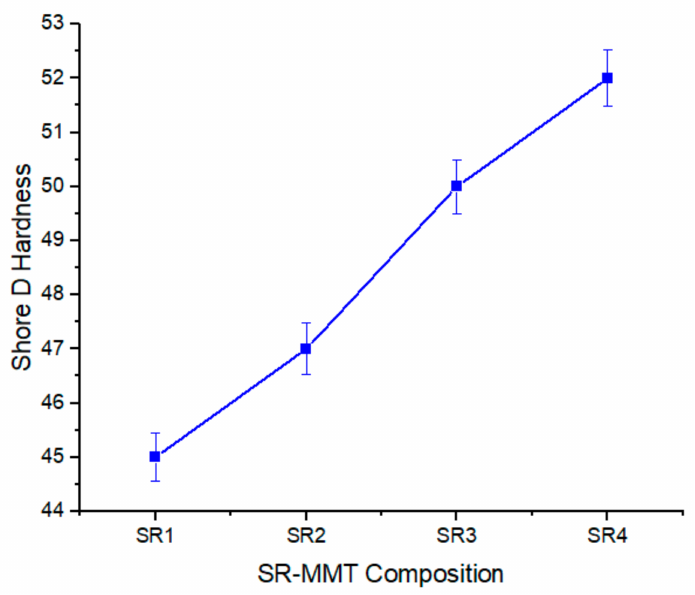
Figure 7. Variation of Shore D hardness for SR/MMT